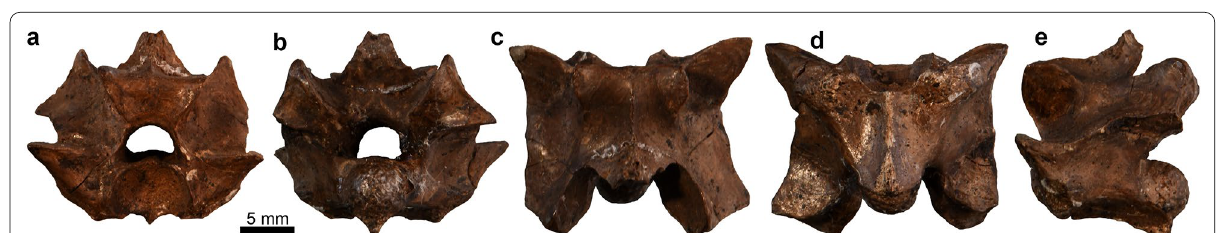
Fig. 28 Palaeopython ceciliensis from quarry Cecilie I, Geiseltal (type locality): anterior/mid-trunk vertebra (GMH Ce I-Y-42-1926) in anterior ( a ), posterior ( b ), dorsal ( c ), ventral ( d ), and left lateral ( e )